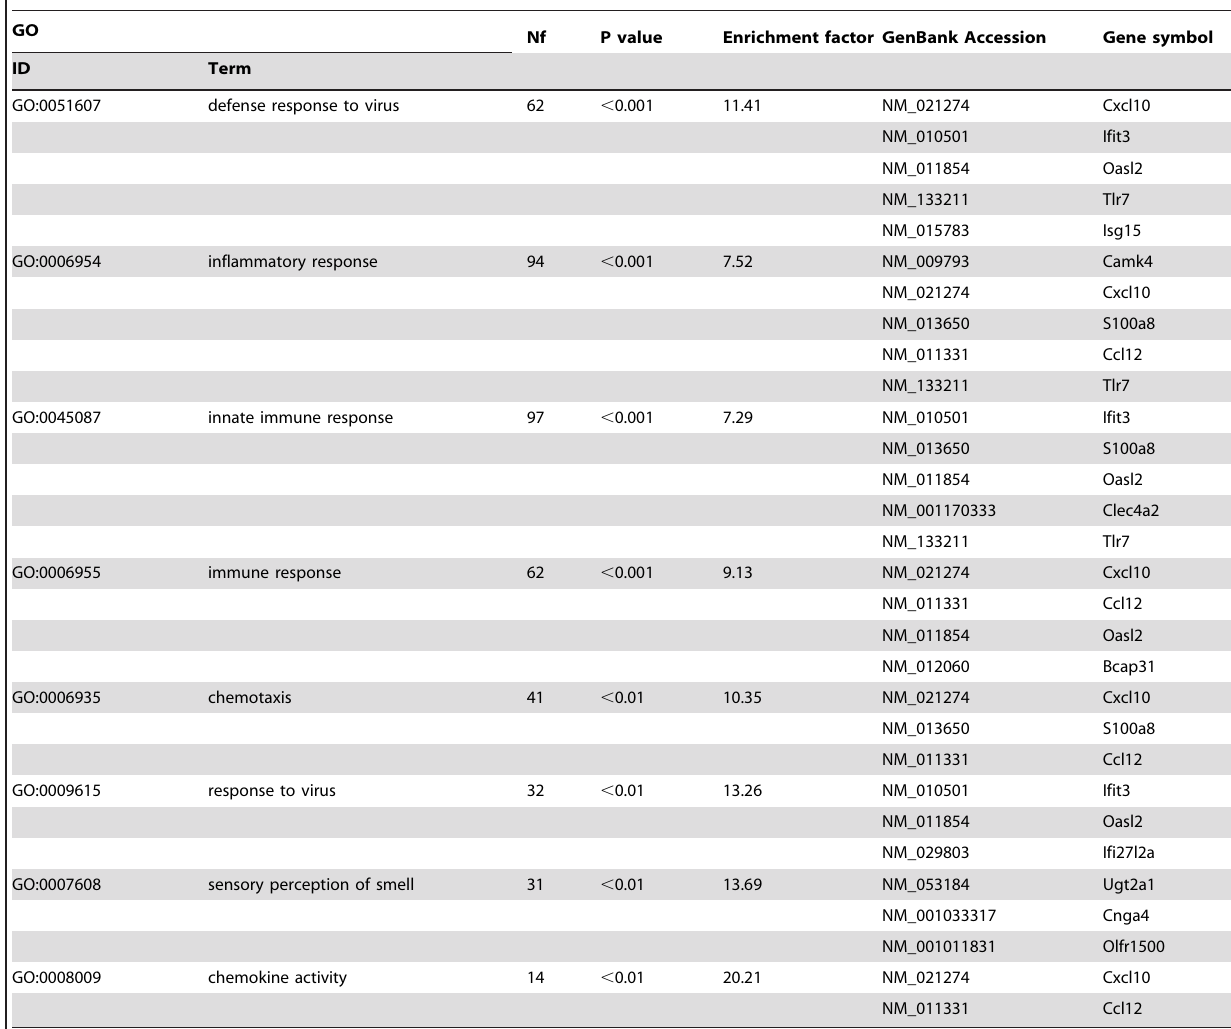
Table 2. Functional analysis of microarray data using Gene Ontology